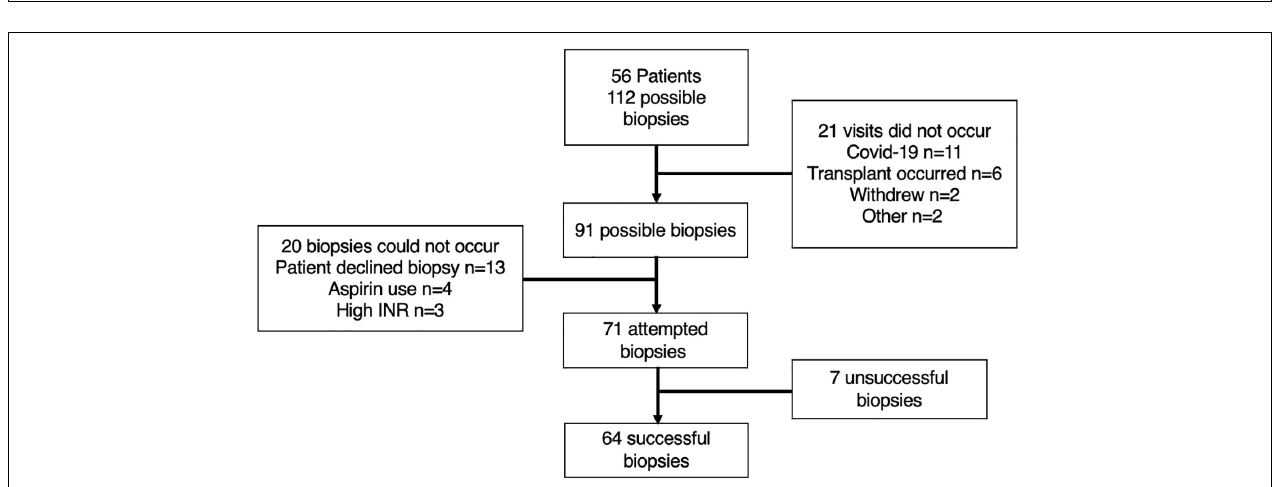
FIGURE 2 | Representative longitudinal ultrasound images of the vastus lateralis (VL) from patients with end stage liver disease. Images obtained from patients with lower (A) and higher (B) body fat percentages (10.5 and 46%, respectively). Solid lines represent the thickness of adipose tissue and dashed red arrow represents the thickness of the VL. Scale on the right-hand side of each image represents cm.